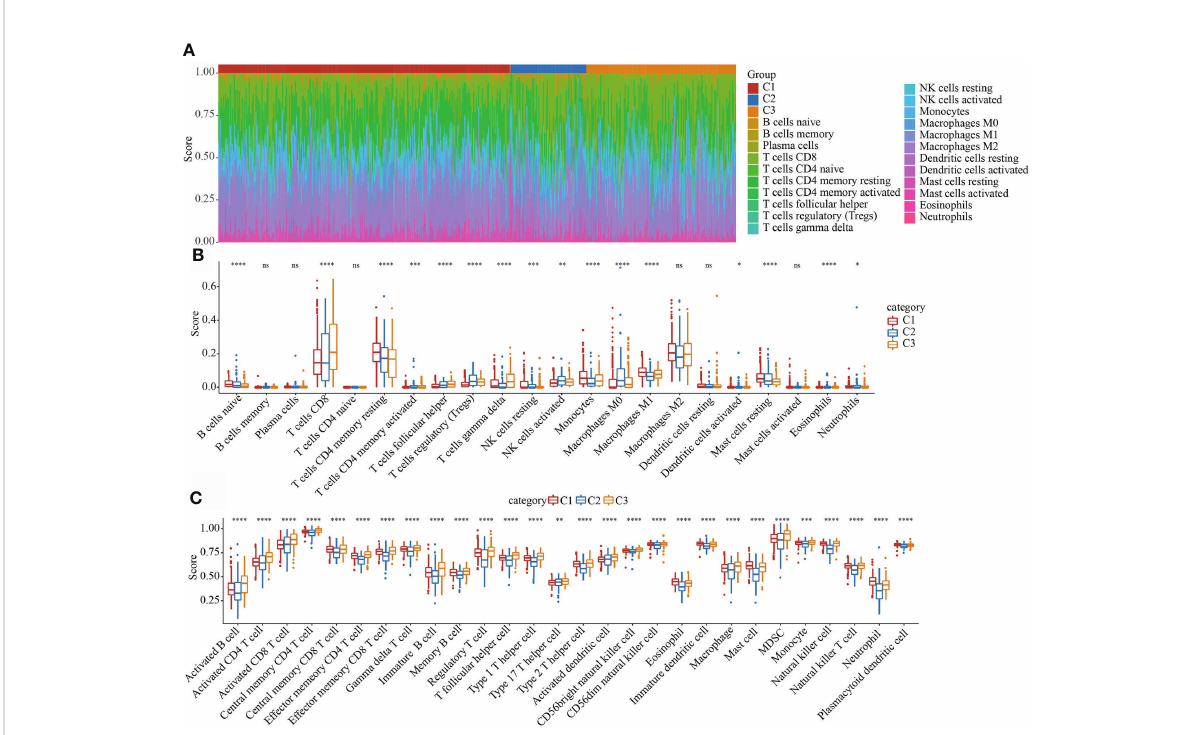
FIGURE 7 Evaluation of immune and pathway characteristics of different molecular subtypes. (A) The proportion of the 22 immune cell components of samples in different subgroups. (B) Differences in 22 immune cell components of samples in different subgroups; (C) Differences in 28 immune in fi ltration scores in different subgroups. *P < 0.05, **P < 0.01, ***P < 0.001. ns, not signi fi